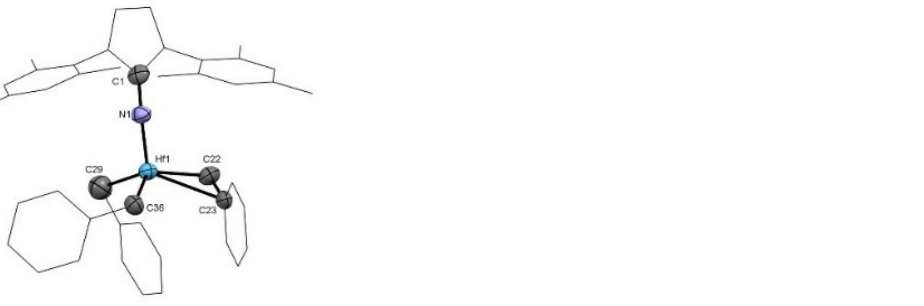
Figure 2. ORTEP drawing of complex 3 [(Im Mes N)Hf(Bn) 3 ]. Hydrogen atoms are omitted for clarity. Comparing complex 3 with complexes 2 or 4 , complex 2 displayed a larger, almost linear Hf-N exocyclic -C ipso angle, with values of 176.3(3)°, 164.1(4)°, and 172.2(3)° for complexes 2 , 3 , and 4 , respectively. The disposition of the benzyl rings in complex 3 enables an agostic interaction with the ipso carbon of one of the benzylic rings (Hf-CH 2 -C aromatic = 88.9(4)°). Despite the similarities among complexes 2 – 4 , a noteworthy difference is the cone angle—124°, 155°, and 262° for complexes 2 – 4 , respectively—as expected given the variable bulkiness of the imidazolin-2-iminato ligands in the corresponding complexes. Furthermore, an outstanding difference between symmetric and asymmetric complexes can be observed by comparing complex 3 with a similar asymmetric complex containing only one mesityl and one methyl group instead of one mesityl substituent at each nitrogen atom (Figure 3). The bulkiness of the abovementioned ligand induces a longer Hf-N bond length in complex 3 of ~0.1 Å. In addition, this asymmetric complex, as expected, displays a small cone angle (125°), enabling the ligand to get closer to the hafnium center [69].